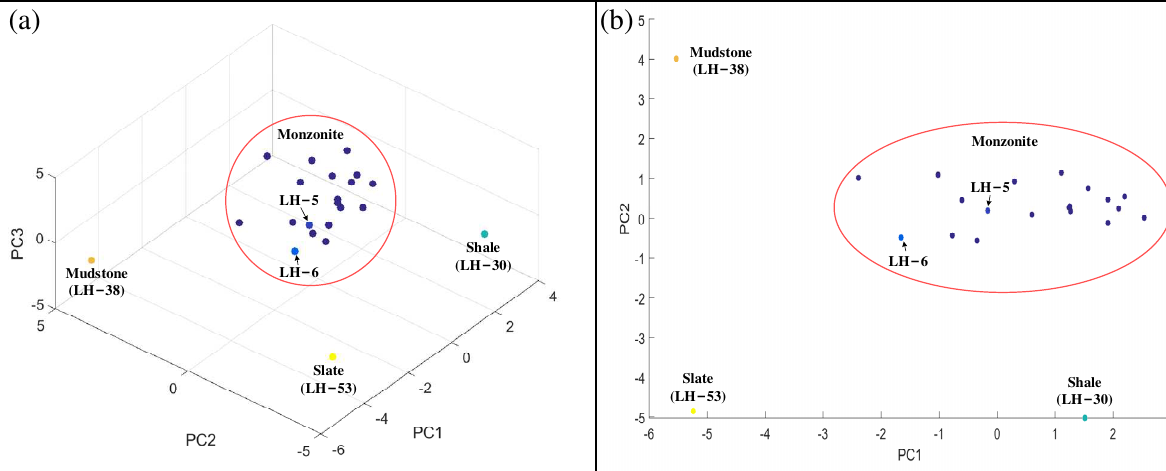
Figure 12. Results assessed by identification model: ( a ) verification result in 3D space (PC1-PC2-PC3), ( b ) verification result in 2D space (PC1-PC2).